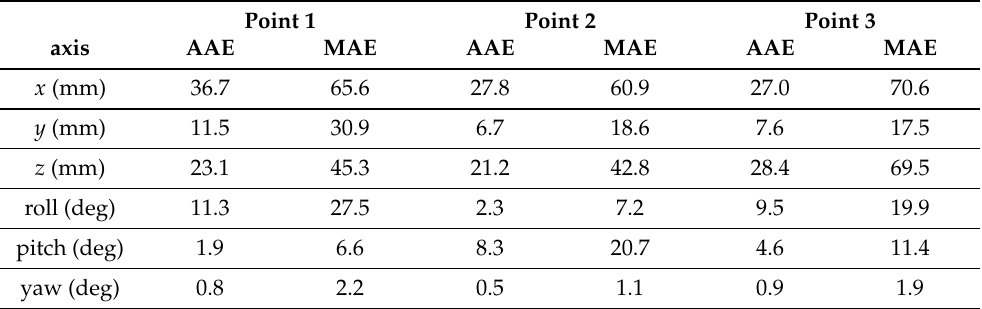
Figure 9. Position estimation errors. Table 1. The average absolute errors (AAE) and the max. absolute errors (MAE) of the position estimation